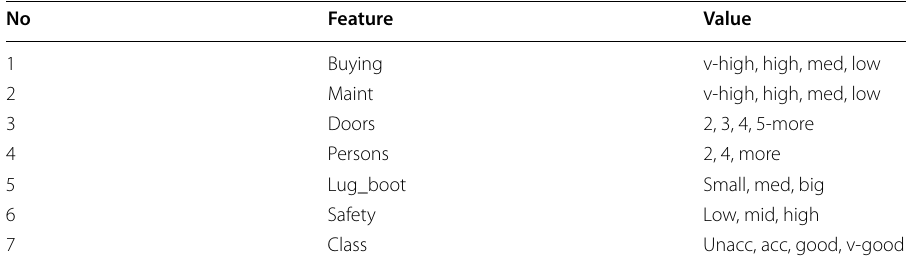
Table 5 Feature description car evaluation